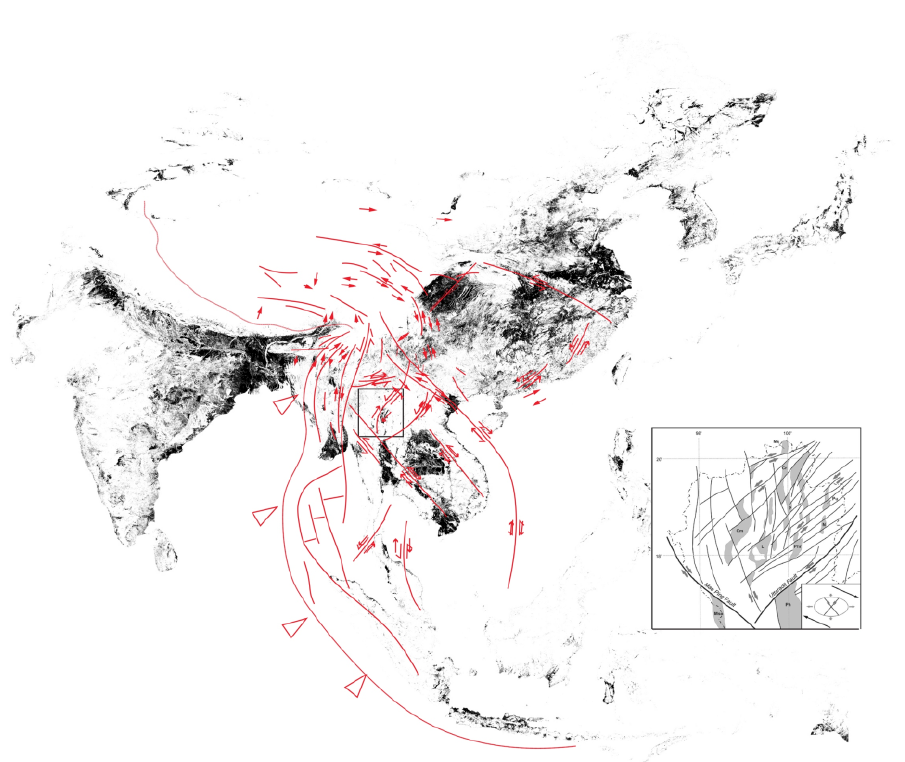
Figure 2. Overlay of tectonic activity created by the subduction of the India under the Eurasian plate in red with areas of rice cultivation in black. Asia Rice map: Andrew Nelson, Murali Krishna Gumma. A map of lowland rice extent in the major rice growing countries of Asia. 2015, 37p. IRRI, Los Banos, Philippines. Inset map of northern Thailand showing the model of Polachan et al. (1991). Shading marks the location of the major basins of northern Thailand within the funnel created by the Ping and Uttaradit